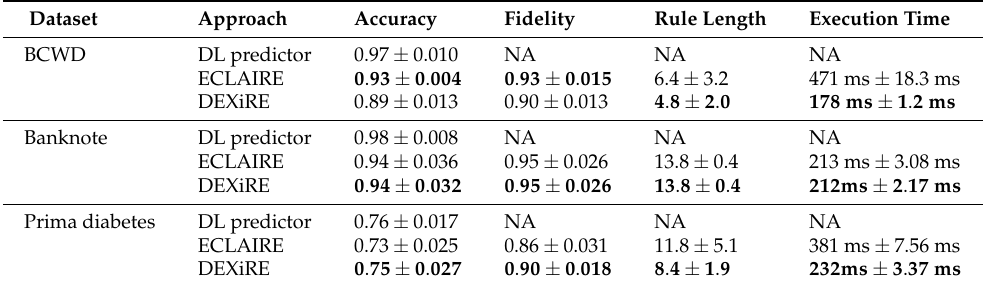
Table 1. Summary table Scenario SC1 (binary classification) showing results for rule-extraction approach, accuracy, fidelity, rule length, and execution time for each dataset. Numerical results are reported with average value ± standard deviation . The best results in each dataset are shown in